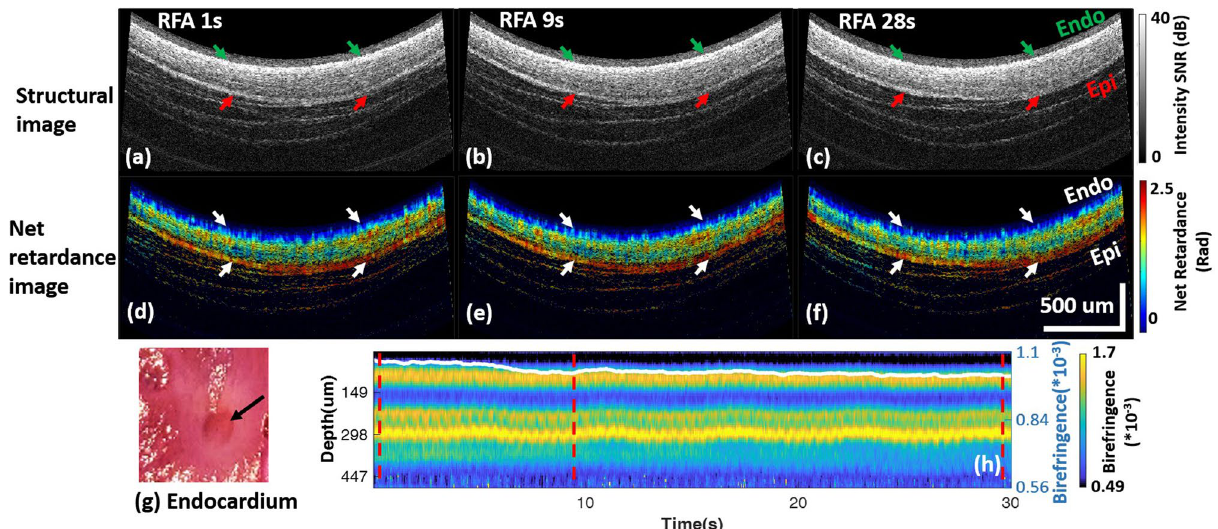
Figure 5. A non-transmural lesion around the RPV. ( a – c ) and ( d – f ) are the structure images and net retardance images of the lesion at 1 s, 8 s, and 29 s of ablation, respectively; ( g ) is a photo of the TTC stained lesion on the endocardium; ( h ) shows the cross-A-line averaged tissue birefringence change and the averaged tissue birefringence change.